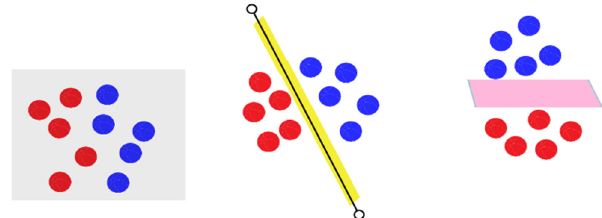
Figure 3. Support vector Figure 3 . Support vector Principle .